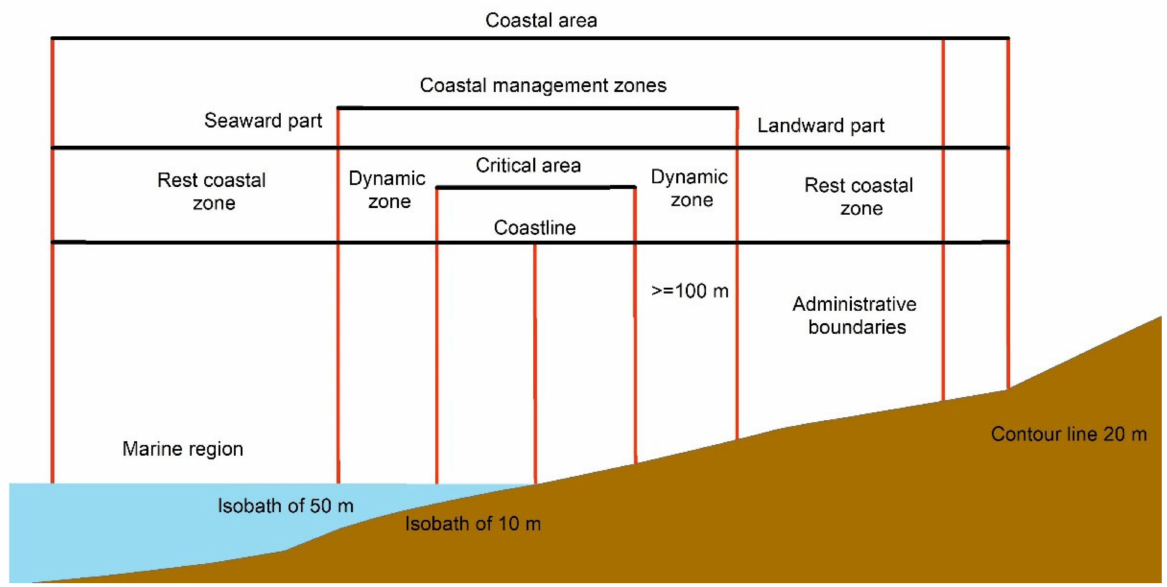
Figure 7. Cross-section of the proposed coastal unit boundaries integrating the developed workflow within the boundaries of the Aegean